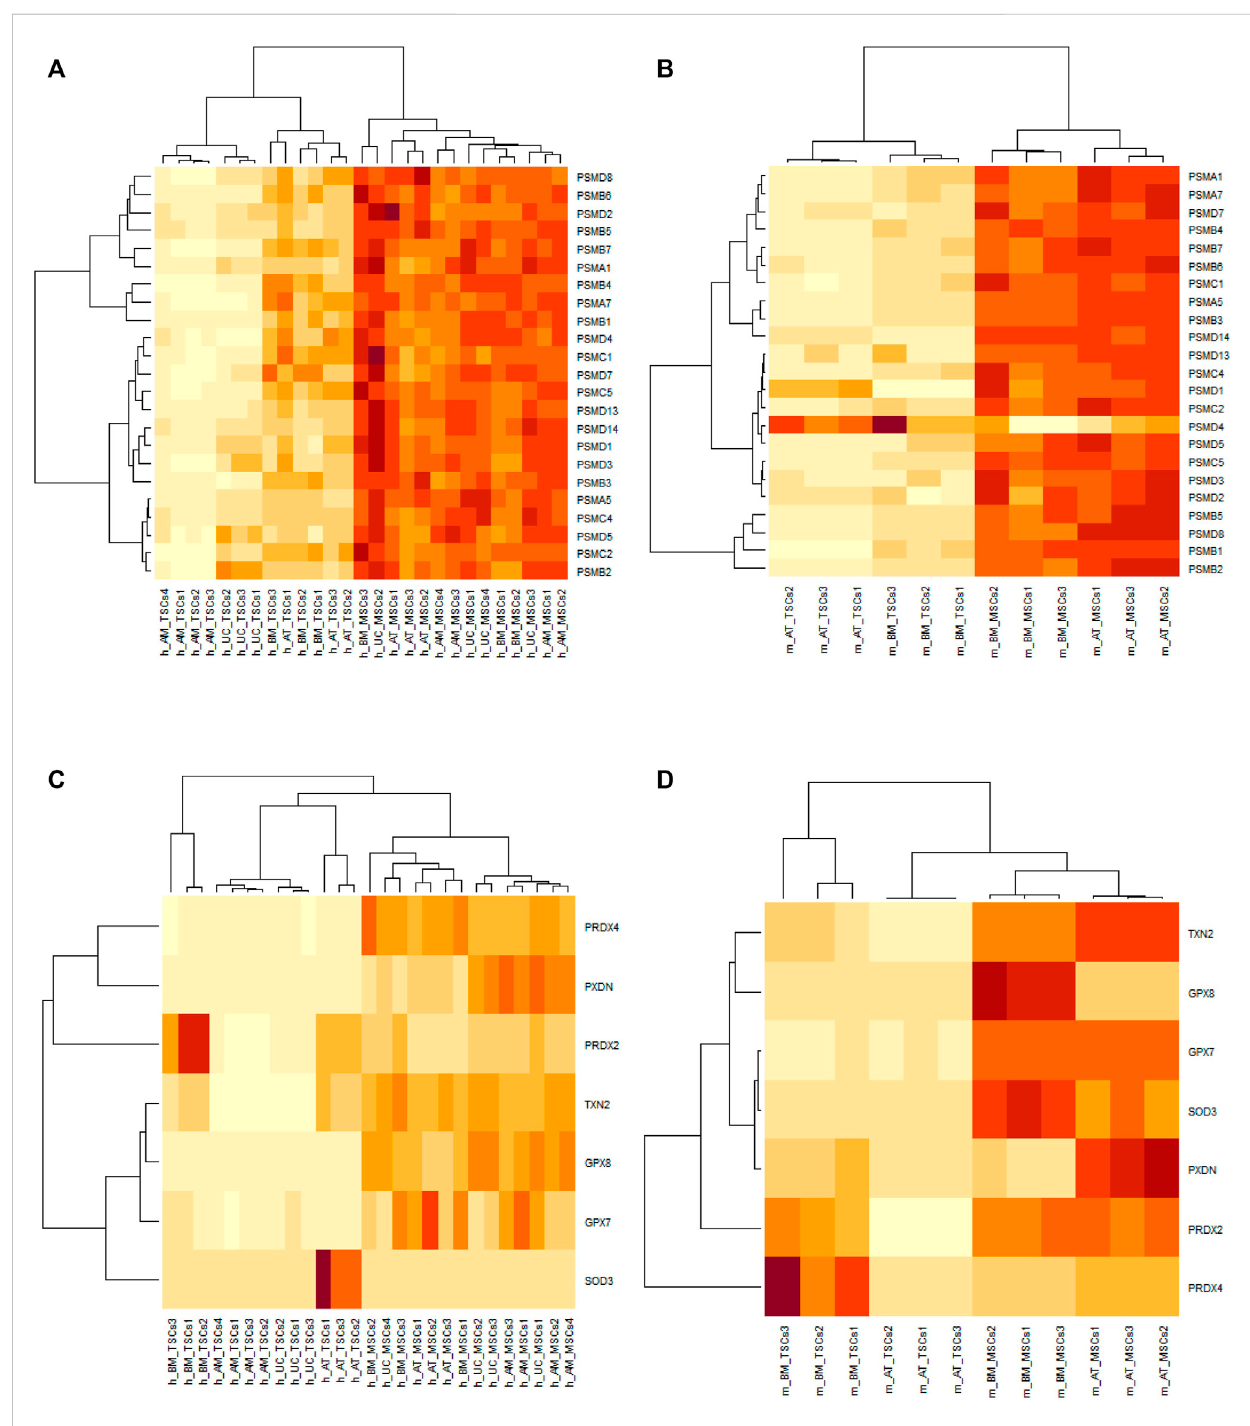
FIGURE 4 Heatmaps of DEGs between MSCs and their TSCs generated by RStudio. Orange indicates upregulation and yellow indicates downregulation. (A) and (B) heatmapsoftheproteasomalgenes ’ expressioninhumanandmousesamples,respectively,showingallgenestobeupregulatedinMSCssamples exceptPSMD4inmouseMSCs. (C) and (D) heatmapsshowingtheexpressionoftheantioxidantgenesisupregulatedinhumanandmouseMSCssamples, respectively, with the exception of SOD3 and PRDX2 in human AT_MSCs and BM_MSCs, and PRDX4 in mouse